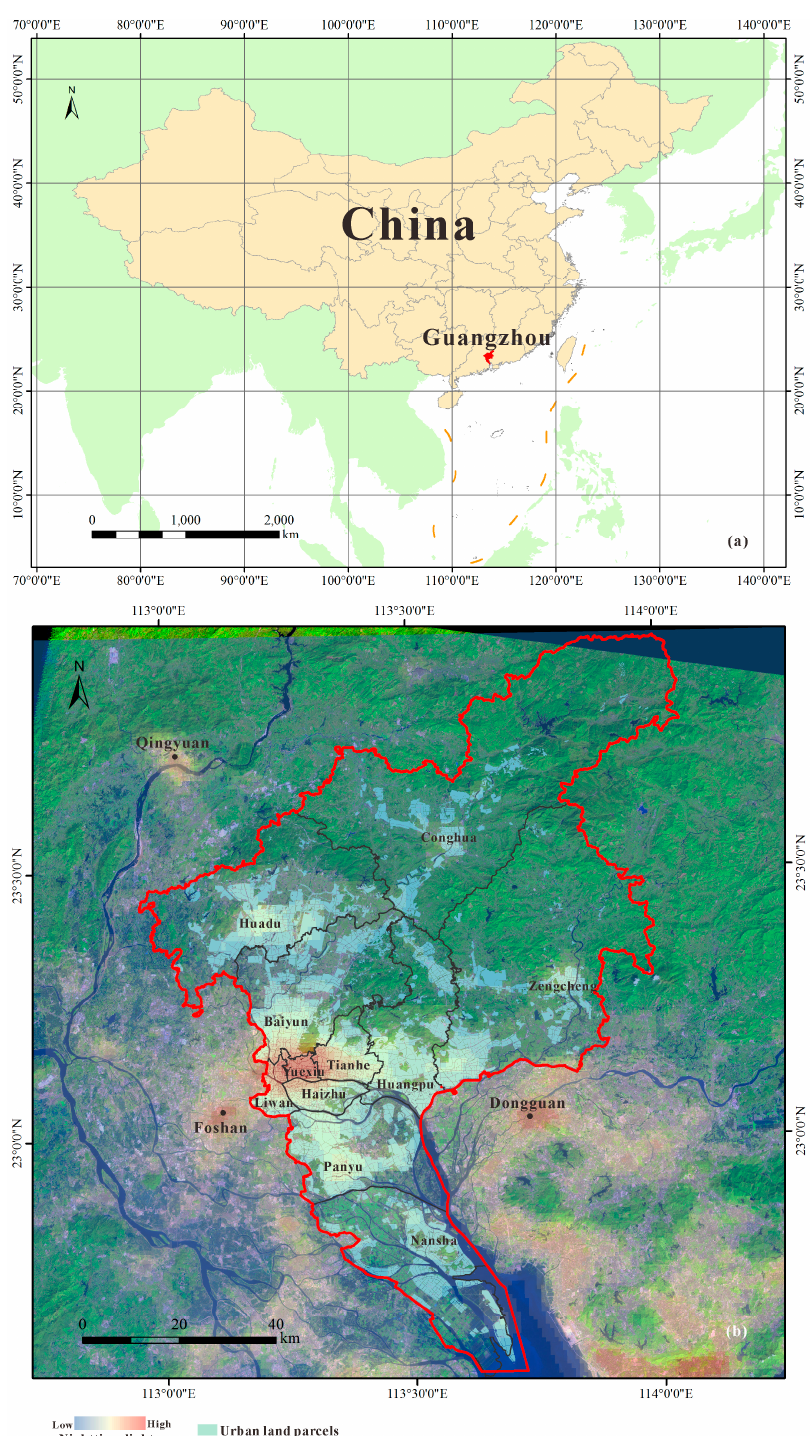
Figure 2. ( a ) Location of the study area: Guangzhou, China. ( b ) Guangzhou has a matured city core (Yuexiu, Tianhe, Haizhu, Liwan and Baiyun), three sub-centers (Panyu, Huadu and Huangpu) and three new growth centers (Conghua, Zengcheng and Nansha).